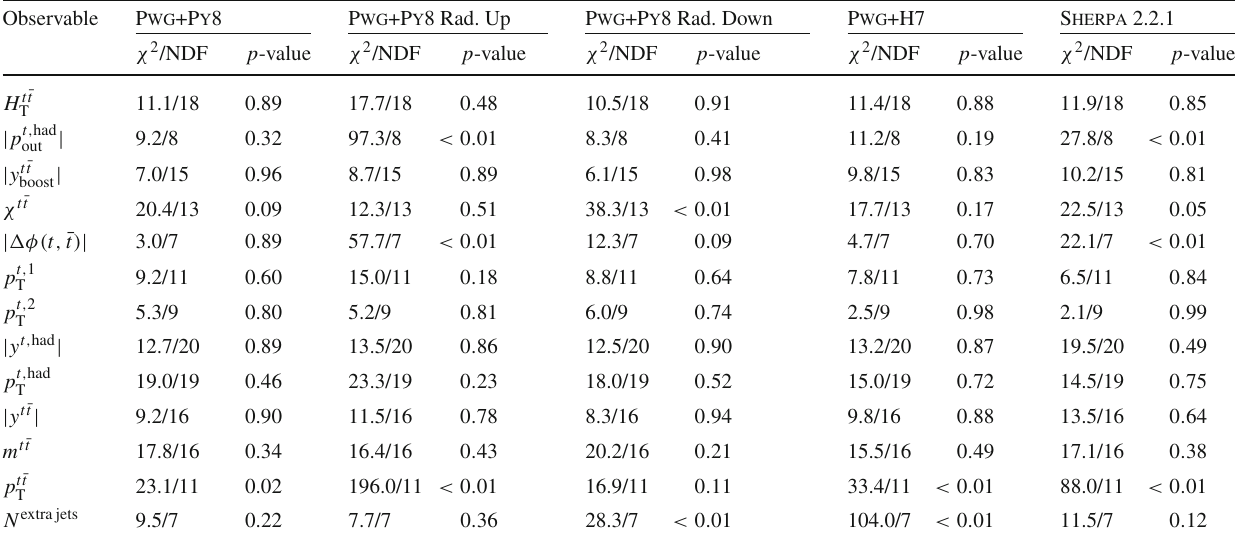
Table 10 Comparison of the measured particle-level absolute single- differential cross-sections in the resolved topology with the predictions from several MC generators. For each prediction a χ 2 and a p -value are